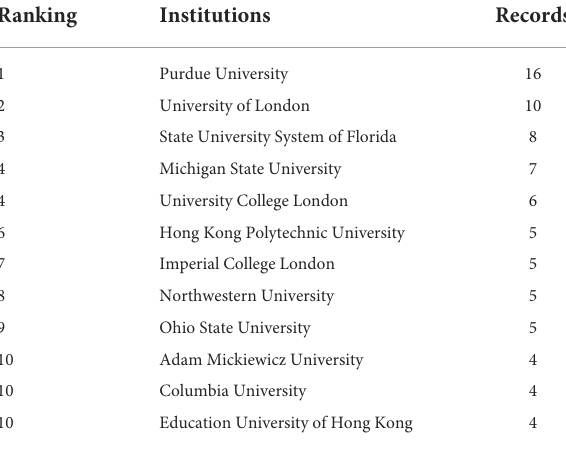
TABLE 2 Top 10 most productive institutions for COVID-19 linguistic research. Ranking